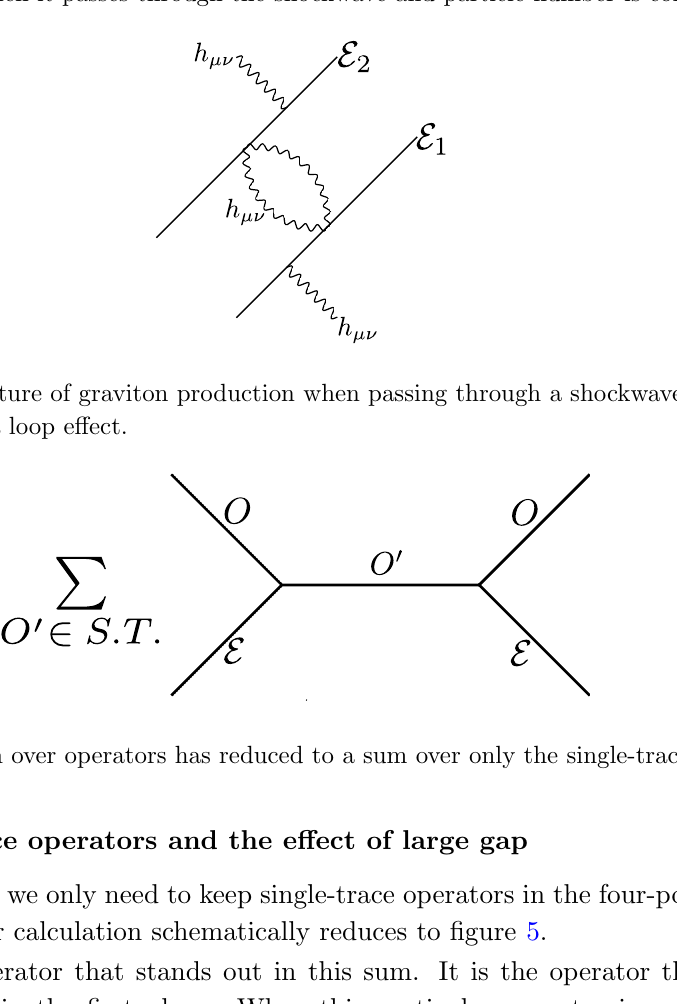
Figure 3 . A bulk picture of a graviton scattering through a shockwave. At tree-level the particle simply gets shifted when it passes through the shockwave and particle number is conserved.